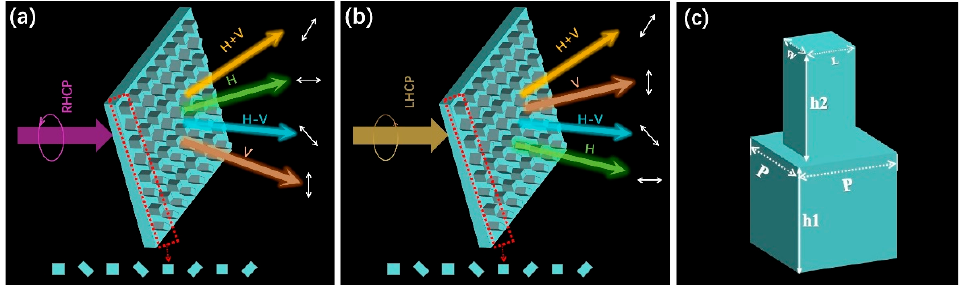
Figure 1. Schematic of the designed structure: ( a ) illustration of the proposed metasurface for complete polarization and phase control under RHCP incidence; ( b ) illustration of the proposed metasurface for complete polarization and phase control under LHCP incidence; ( c ) schematic of a basic unit, which is a rectangular silicon pillar patterned on a square silicon substrate.